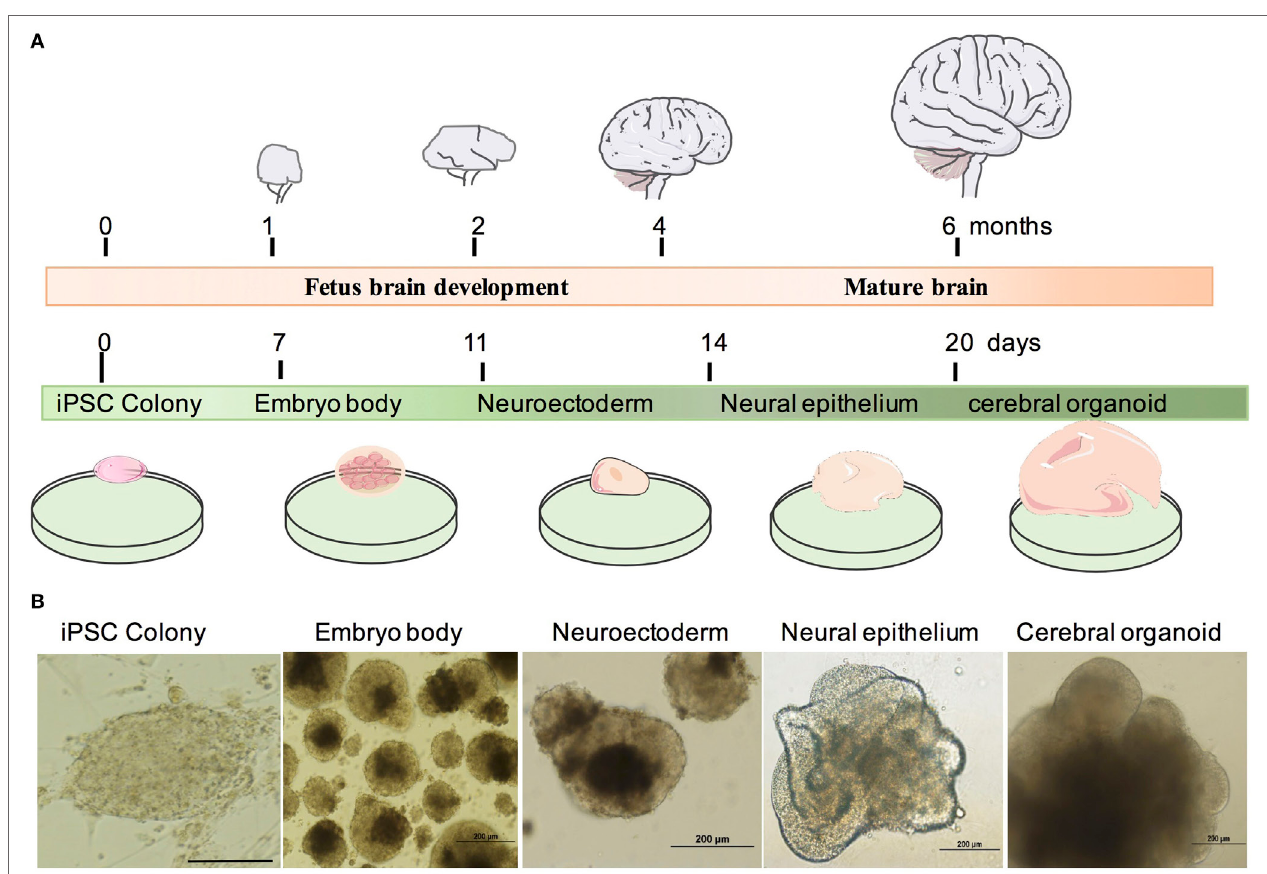
FigUre 1 | Generation of human human-induced pluripotent stem cell (iPSC)-derived cerebral organoid system. (a) Timeline of in vivo brain and cerebral organoid development. (B) Example of cerebral organoid from human iPSCs. Human iPSCs form embryo bodies, developed into neuroectoderm and finally differentiated into neural epithelium and cerebral organoids. Scale bars: 200